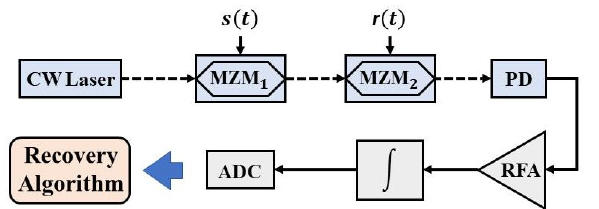
Figure 5. Scheme of the proposed CS system. CW laser: continuous wave laser; MZM: Mach– (cid:82) Zehnder modulator; PD: photodiode; RFA: amplifier; : integrator; ADC: analog-to-digital converter; dashed line: optical link (single mode fiber); solid line: electrical